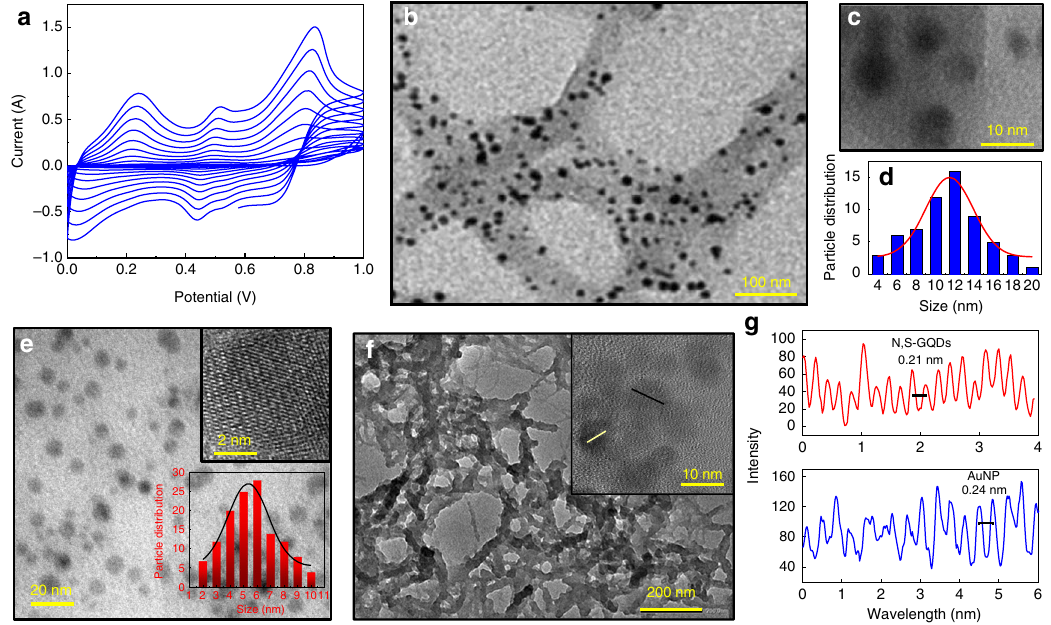
Fig. 2 Characterizations of polyaniline deposition, N,S-GQDs and Au-PAni preparation and N,S-GQDs@AuNP-PAni nanocomposites: a cyclic voltammograms of electropolymerized PAni fi lm on the GCE electrode, b TEM image of AuNP-PAni nanocomposites, c high magni fi cation of AuNP on the PAni chain, d size distribution of the AuNPs inside the AuNP-PAni nanocomposites, e TEM image of N,S-GQDs (inset: HRTEM image of an isolated N,S-GQD and the size distribution), f TEM image of N,S-GQDs@AuNP-PAni nanocomposites (inset: HRTEM of a small area), and g fringe patterns of N,S-GQDs and AuNP from the HRTEM image of N,S-GQDs@AuNP-PAni nanocomposites